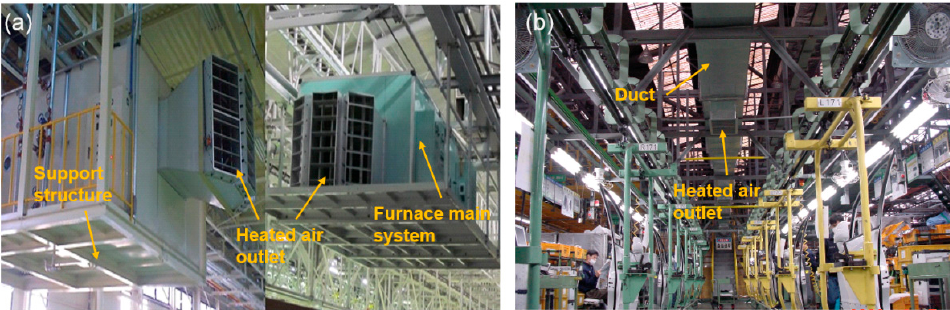
Figure 2. Heating facilities used in the large-scale assembly factory. ( a ) Furnace; ( b ) Duct of hot water fan coil system.